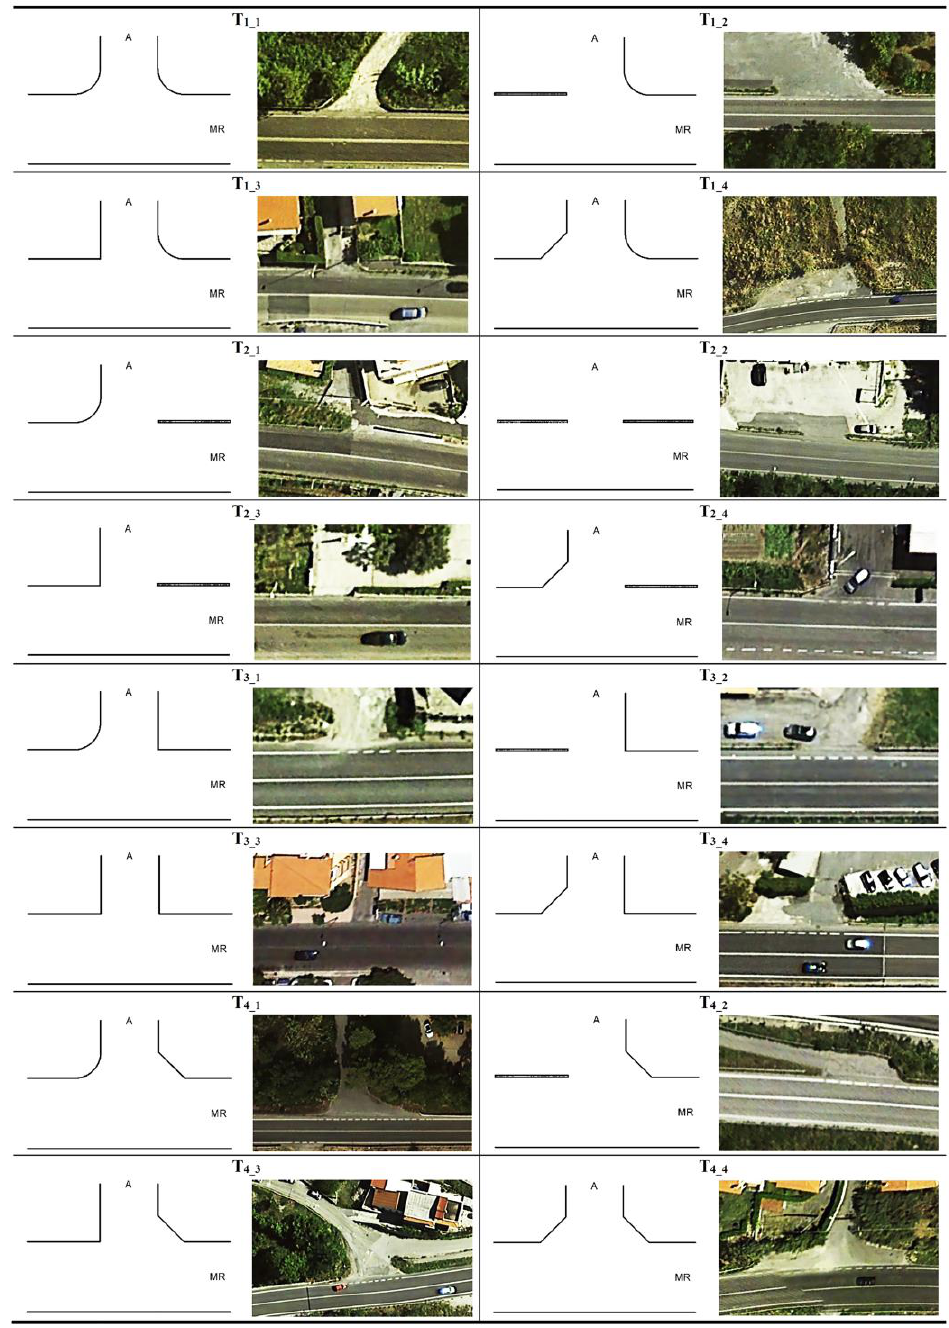
Figure 7. Types of access points: schematic geometry and examples (top view; MR = main roadway; A = access point; aerial images ©